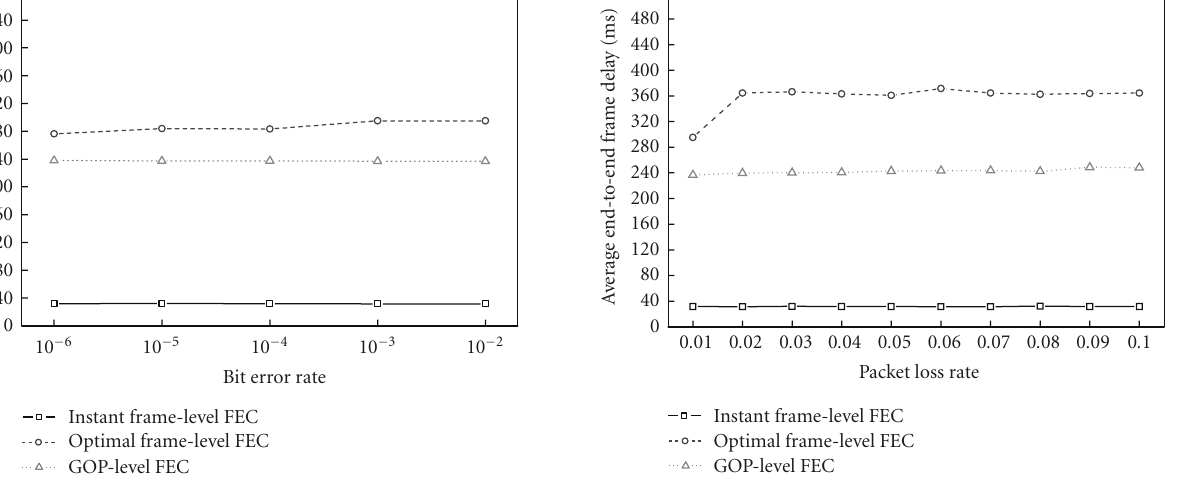
Figure 11: Comparison of end-to-end frame delays with varied bit error rate.